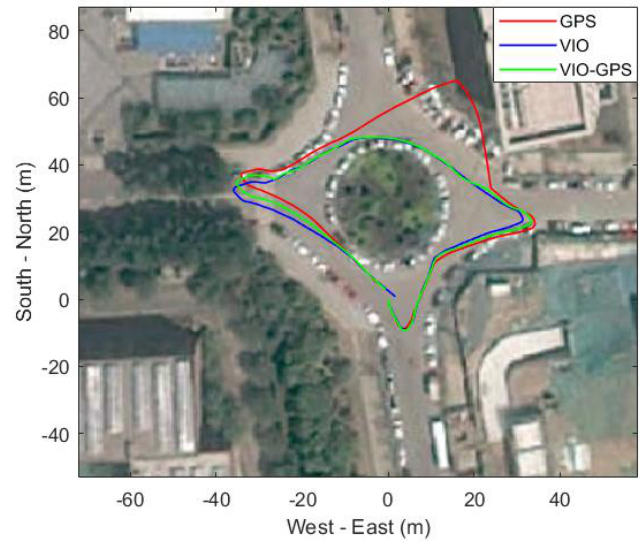
Figure 13. 2D UGV trajectory tracking.